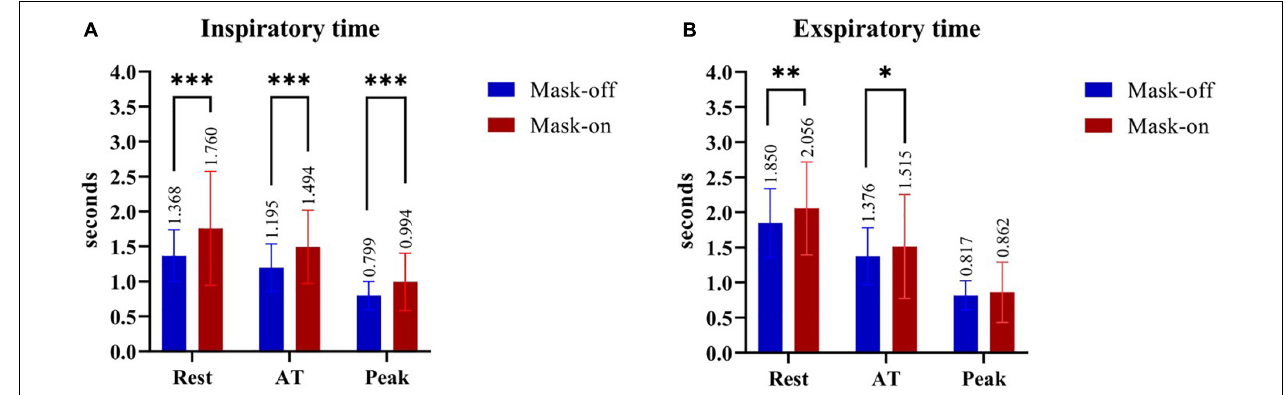
FIGURE 3 | The comparison between mask-on and mask-off condition in the inspiratory time (A) and expiratory time (B) during different stages of the CPET, respectively. * P ≤ 0.05; ** P ≤ 0.01; *** P ≤ 0.001. AT, anaerobic threshold; CPET, cardiopulmonary exercise